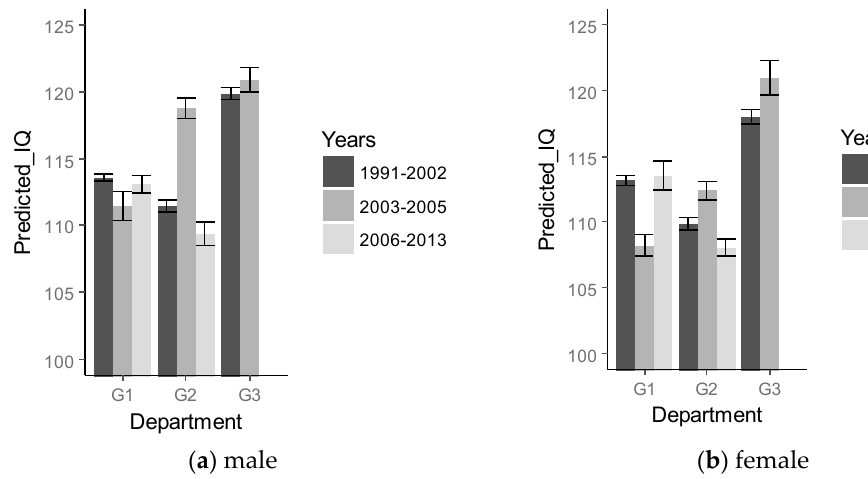
Figure 3. Dynamics of general IQ test among male ( a ) and female ( b ).